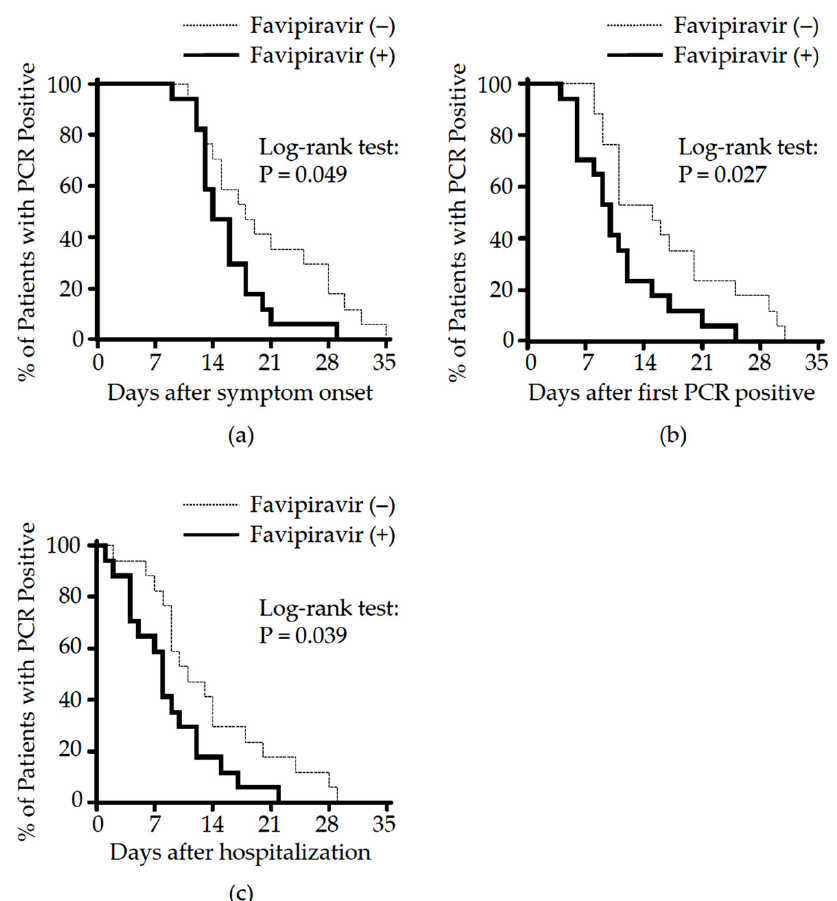
Figure 1. Effect of favipiravir on viral clearance in patients with moderate COVID-19. Kaplan–Meier curves of time to viral clearance from ( a ) symptom onset, ( b ) first day of positive PCR test (equivalent to the terms of PCR positive duration), and ( c ) hospitalization were made for case (solid line) and control (dotted line) and analyzed using the log-rank